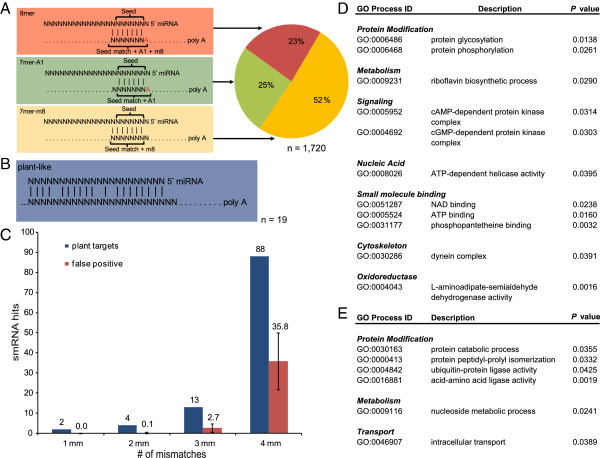
smRNA target prediction for 21 smRNAs within the gene set of Symbiodinium microadriaticum. (A) 3 distinct animal-like target sites in the 3'UTR of genes exist that are characterized by seeds of lengths 6-8nt that display perfect complementary base pairing between the miRNA and mRNA sequence. Vertical dashes indicate Watson-Crick base pairing. The pie chart displays the relative frequency of these target sites in the 3'UTRs of 1,720 genes (from a set of 12,858 genes with available 3'UTRs). (B) 19 plant-like mRNA target sites were identified in the coding sequence and 3'UTRs of 51,917 genomic genes of Symbiodinium microadriaticum. Plant-like mRNA target sites are characterized by full-length complementary base pairing between a miRNA and its mRNA with only few mismatches (i.e. near-perfect). (C) Number of identified plant-like mRNA target sites (blue bars) in relation to number of mismatches allowed. Number of false positives in 1,000 randomly generated cohorts of small RNA sequences of length 22 nt (red bars) are displayed for comparison. A cutoff of 3 mismatches (mm) over the aligned smRNA and mRNA provides a False Positive Rate of about 1 in 5. (D) Enriched GO terms within the set of matching and annotated animal-like targets (n = 519, P < 0.05, 4,047 3' UTRs). (E) Enriched GO terms within the set of matching and annotated plant-like targets (n = 7, P < 0.05, 18,290 genes).